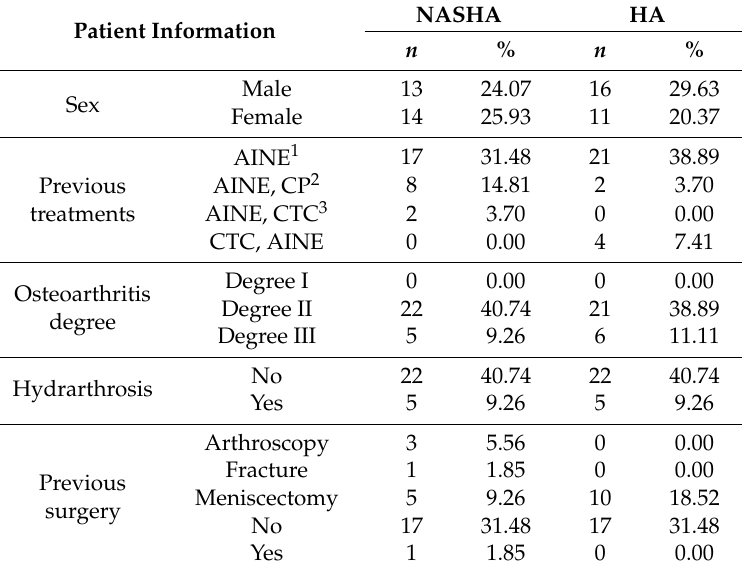
Table 3. Patient distribution according to sex, previous treatment, degree of osteoarthritis, hydrarthrosis, and previous